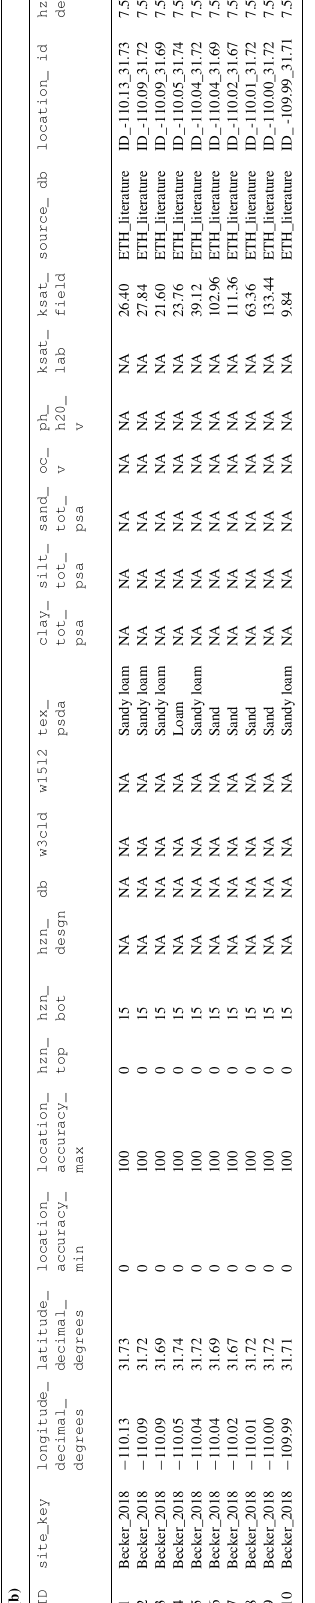
Table 3. Number of samples ( N ) assigned to each spatial accuracy class. NA are samples without information on spatial